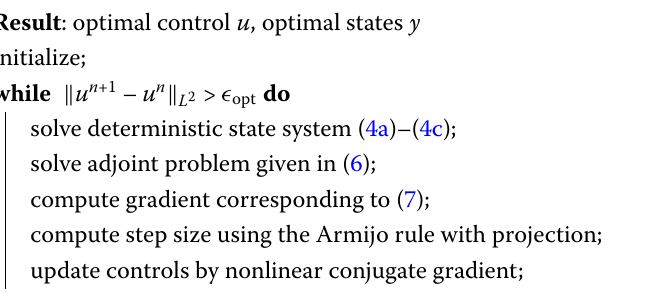
Algorithm 2: Optimal control algorithm for the coarse